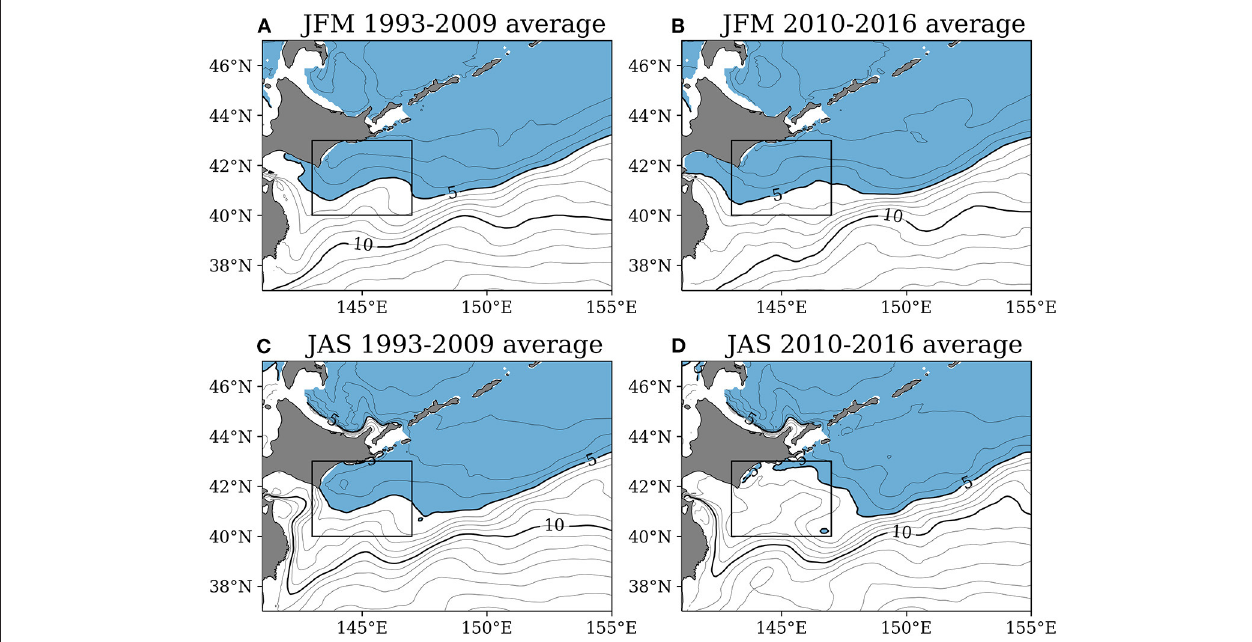
FIGURE 11 | Temperature at 100m depth of the FRA-JCOPE2 reanalysis (contour). The temperature of < 5 ◦ C is colored blue. (A) The 1993–2009 average in JFM. (B) The 2010–2016 average in JFM. (C) The 1993–2009 average in JAS. (D) The 2010–2016 average in JAS.